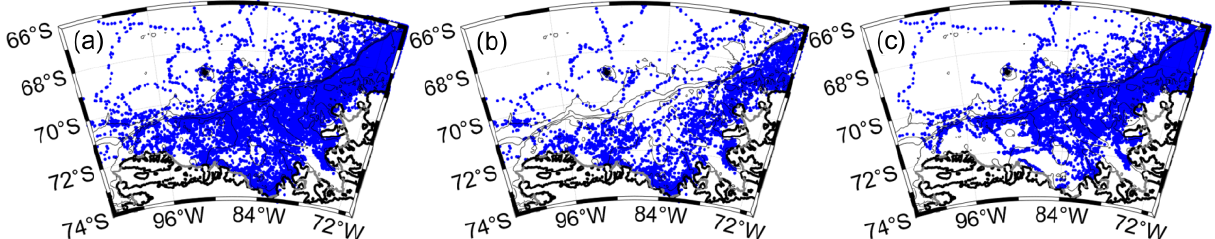
Figure 2. Distribution of (a) all seal data, (b) seal data in summer months (October–March), and (c) seal data in winter months (April– September) from the Marine Mammals Exploring the Oceans Pole to Pole (MEOP-CTD) database within the Bellingshausen Sea. Contours are the same as in Fig. 1.